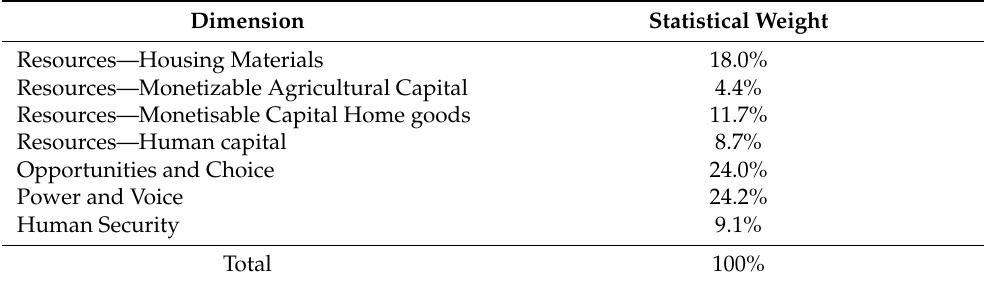
Table 4. Composition of the Multidimensional Poverty Index for the rural area of the Tupiza River Basin.